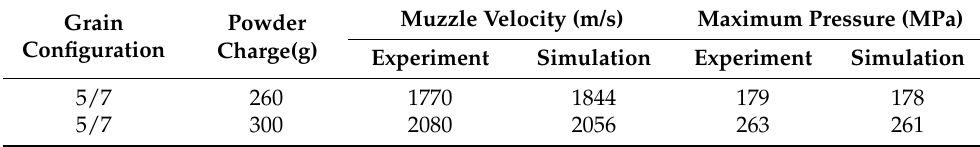
Table 3. Comparisons of experimental and numerical